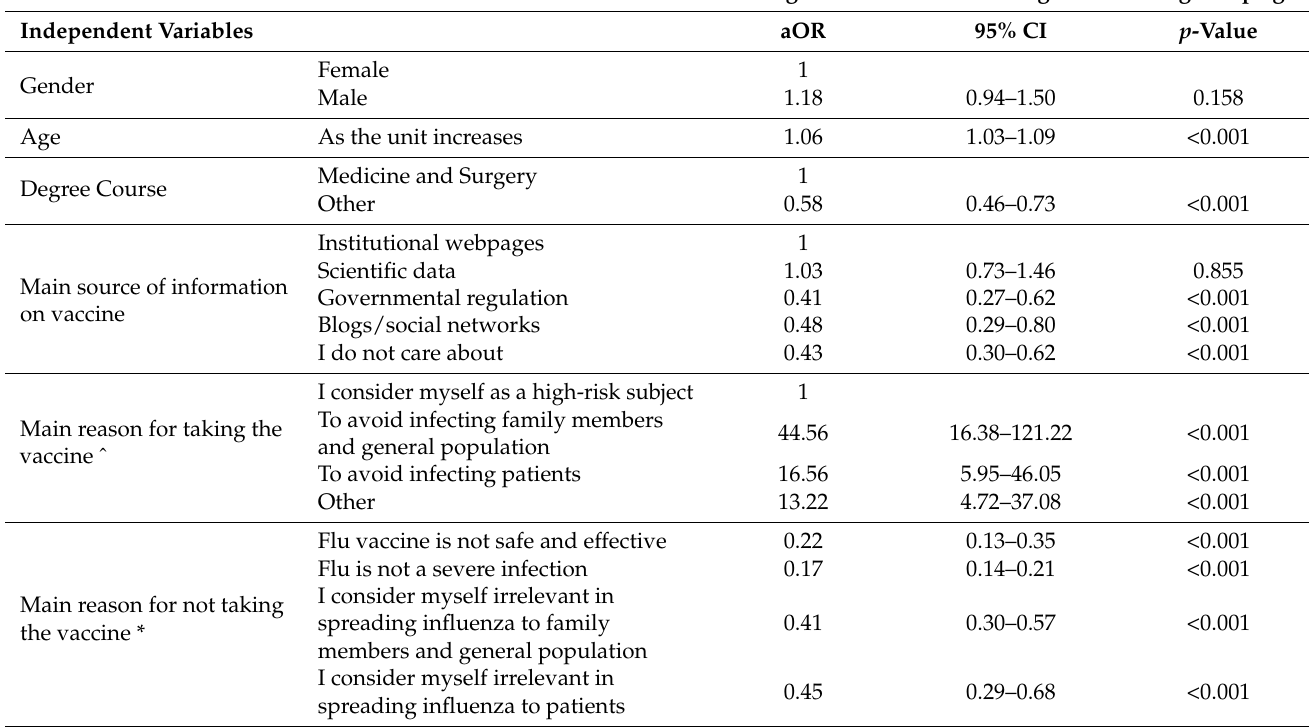
Table 3. Multivariable logistic regression for getting influenza vaccine during the following campaign. Adjusted Odds Ratios (aOR) are presented. Each independent variable is adjusted for gender and age. Based on 3131